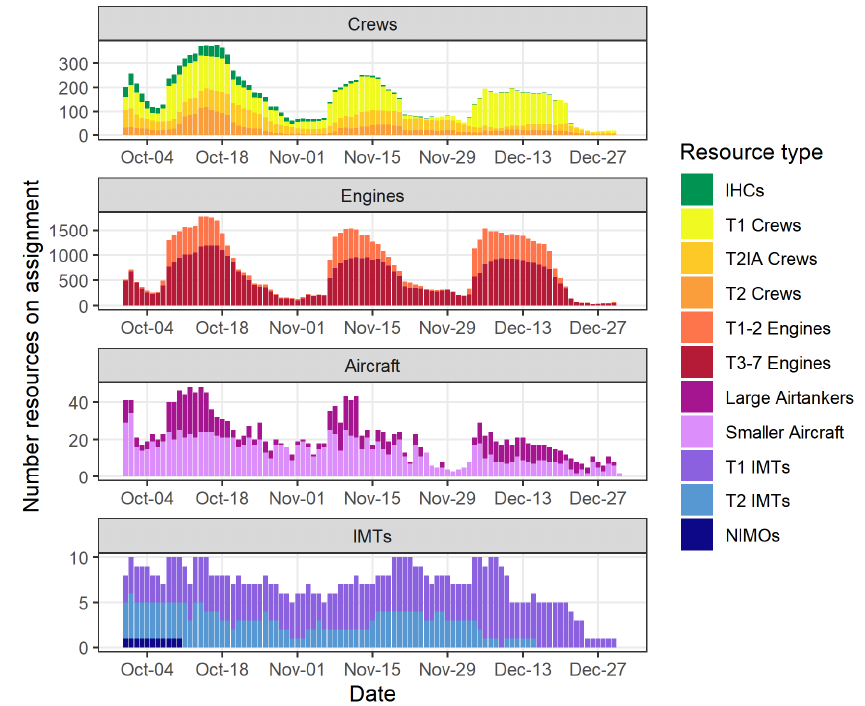
Figure 8. Maximum daily resource-use scenario results. A visualization of resources that could have been requested daily in the maximum daily resource use scenario.